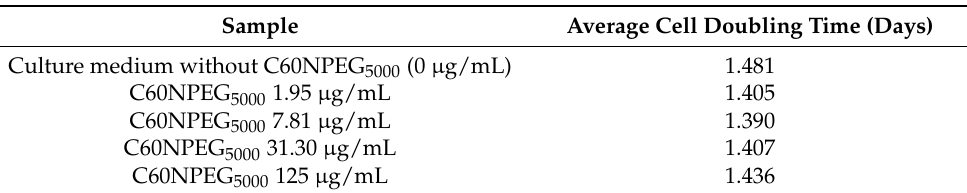
Table 1. Average values of doubling time determined for human osteoblasts (hFOB 1.19 cell line, ATCC CRL-11372 TM ) after incubation with selected concentrations of C60NPEG 5000 solution. Cells incubated with culture medium without C60NPEG 5000 (0 µ g/mL) was used as a control of experiment.